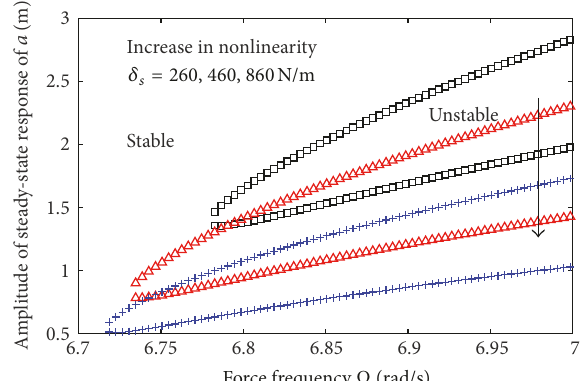
Figure 9: The effect of varying nonlinear stiffness 𝛿 𝑠 on unstable area of vibration 𝑎 . 𝛿 𝑠 = 260 N / m ( black squares), 𝛿 𝑠 = 460 N / m (red triangles), and 𝛿 𝑠 = 860 N / m (blue crosses).